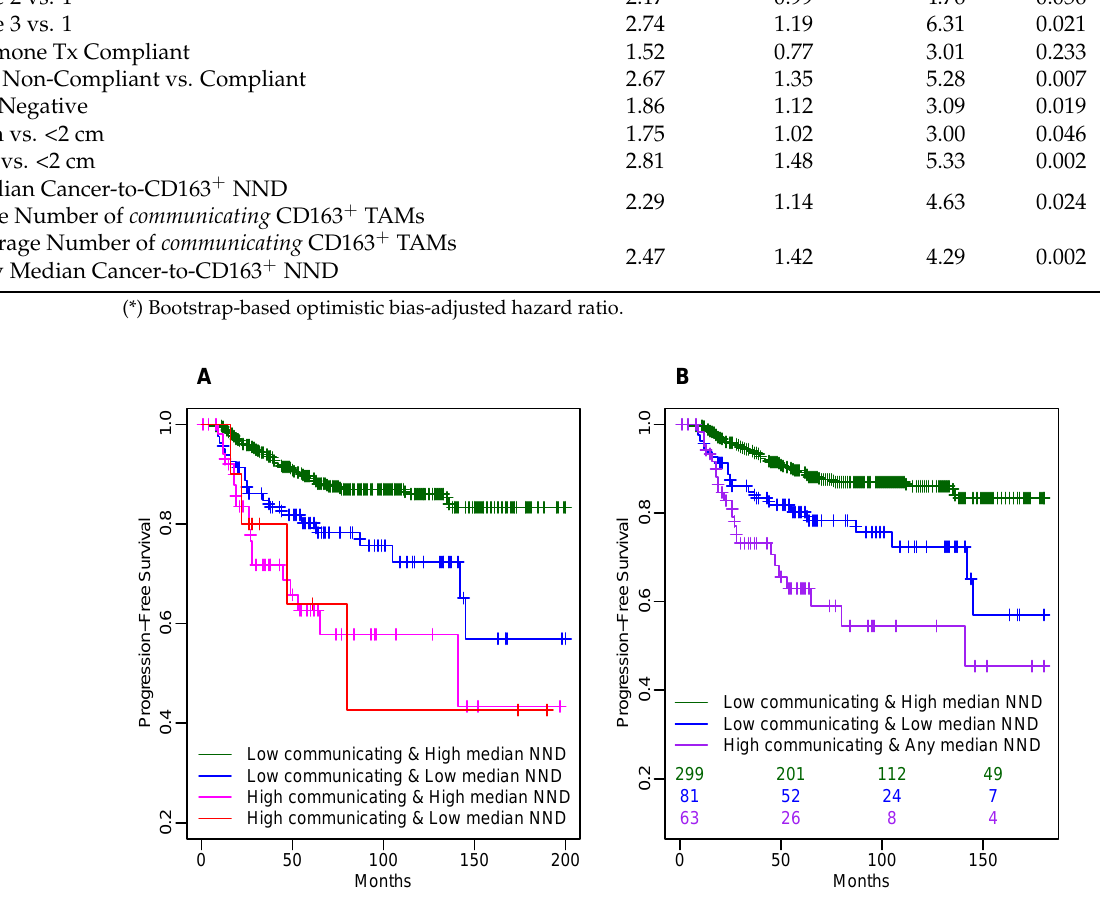
Figure 4. Kaplan–Meier plots of PFS by combined CD163 + TAM marker based on high vs. low aver- age number of communicating CD163 + cells and high vs. low median NND. ( A ) by four combinations of low/high average number of communicating CD163 + cells and low/high median cancer-to-CD163 + NND; ( B ) by combined CD163 marker with 3 categories: (1) low average number of communicating CD163 + cells and high median cancer-to-CD163 + NND; (2) low average number of communicating CD163 + cells and low median cancer-to-CD163 + NND; (3) high average number of communicating CD163 + cells and any median cancer-to-CD163 +